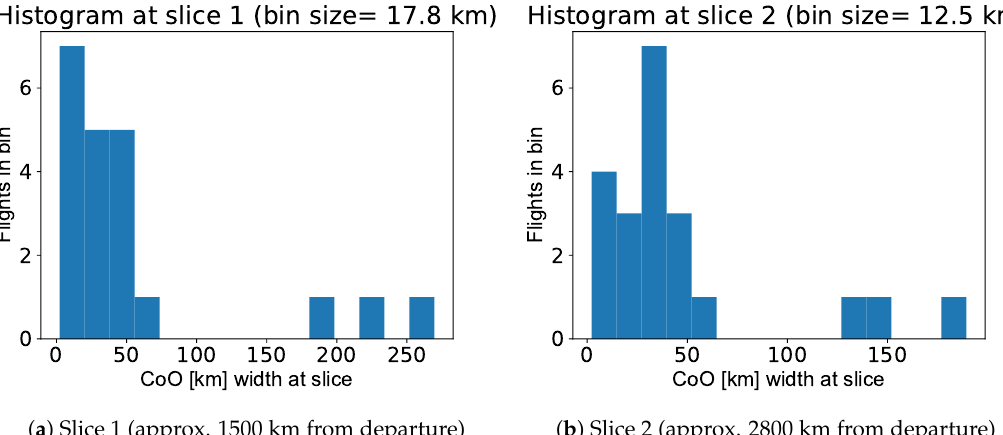
Figure 10. Histogram of the lateral distribution of flights in the CoO for two slices (dark green lines in Figure 9). The measurement of the width starts at the southern border of the